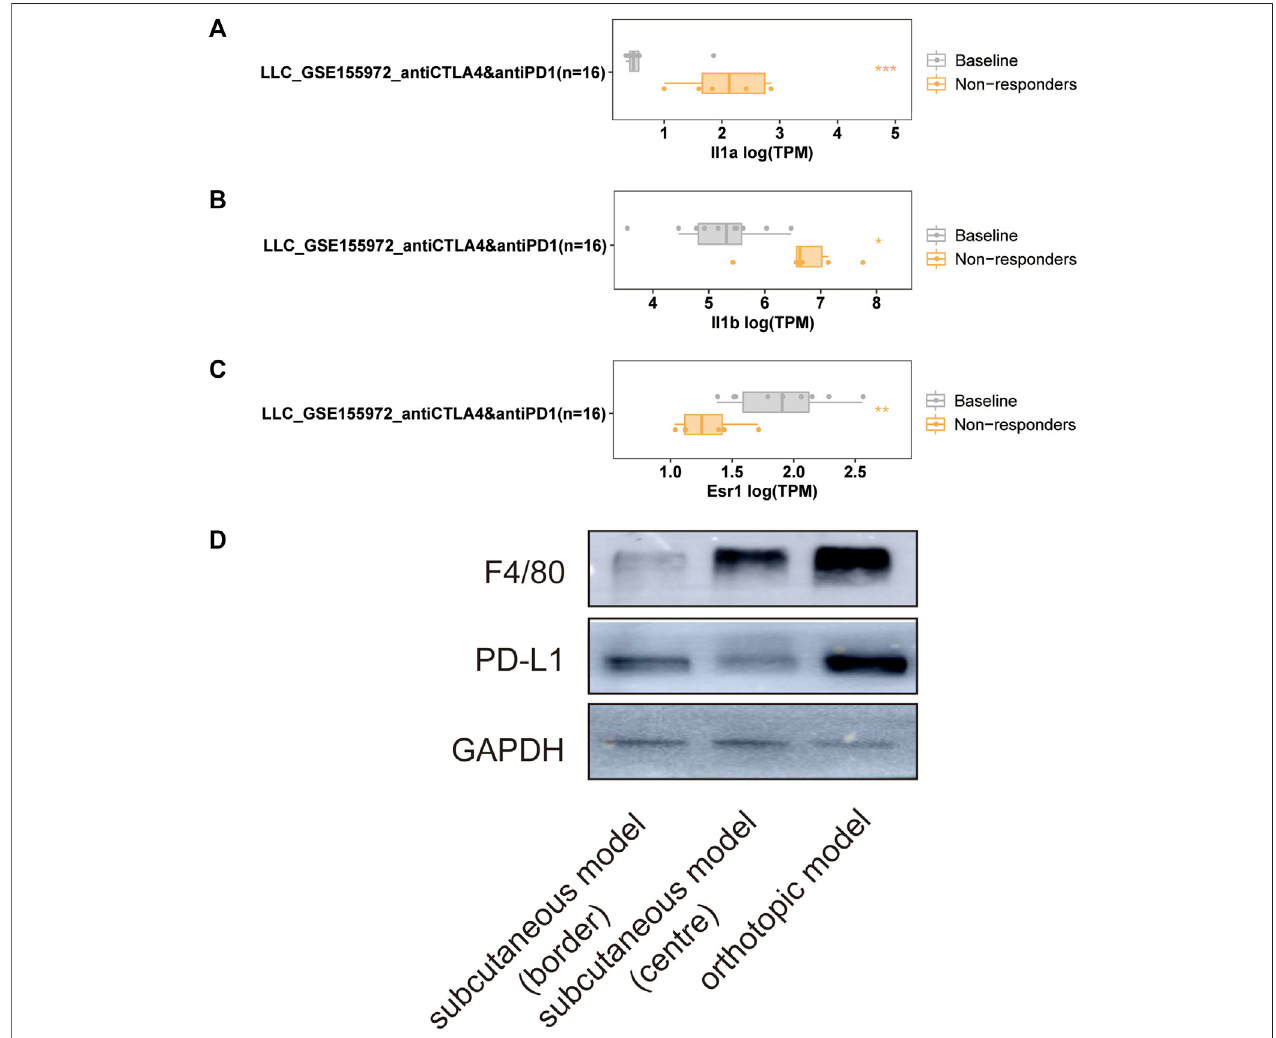
FIGURE 7 | Signi fi cantly different expressions of IL1A (A) , IL1B (B) , and ESR1 (C) from the LLC mouse model in different groups of mice treated with immune checkpoint inhibitors. The markers of macrophage (F4/80) and classic immune checkpoint (PD-L1) inhibitor were expressed differently among the border, the center of the subcutaneous model, and the orthotopic model of LLC (D)